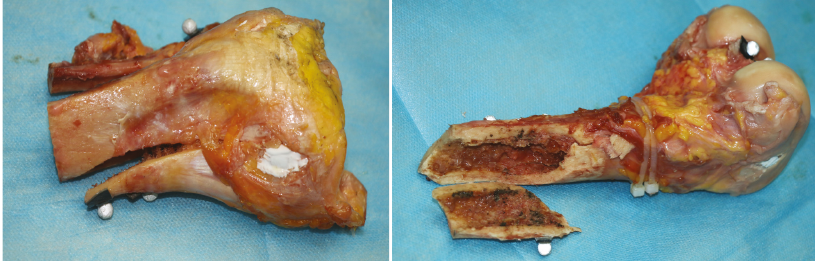
Figure 3: A fractured joint specimen at an impact speed of 8km/h.